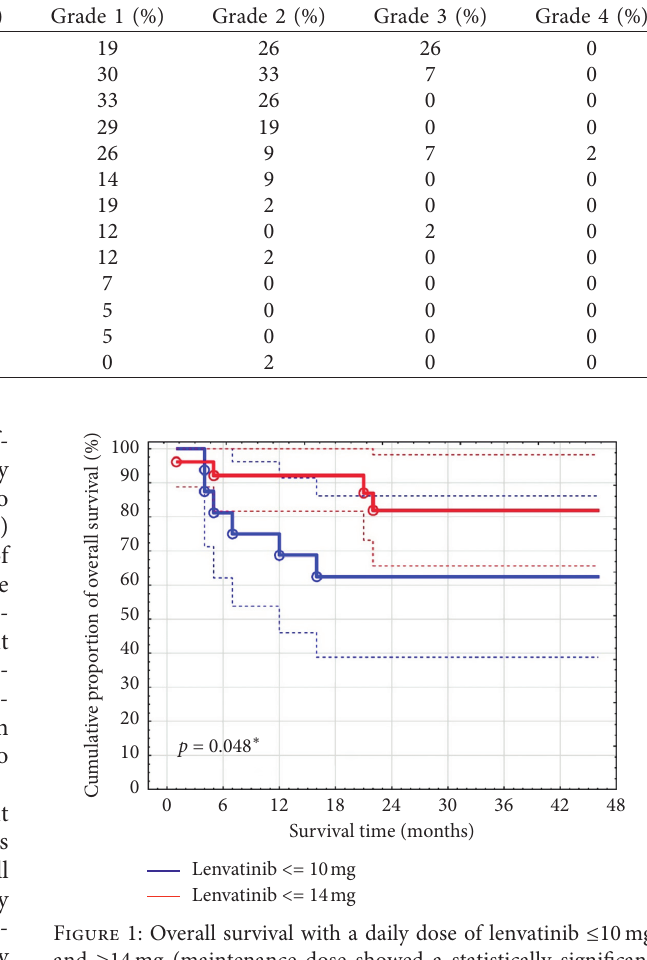
Table 2: Overview of adverse events.